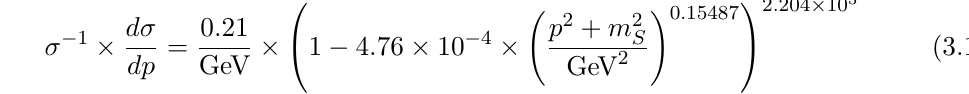
Figure 5 . Left panel: Sgoldstino production cross section in the gluon fusion at √ evaluated for M 3 = 3 TeV and F = 10 TeV. Right panel: Differential cross section as a function of sgoldstino energy E S for a set of sgoldstino masses m S